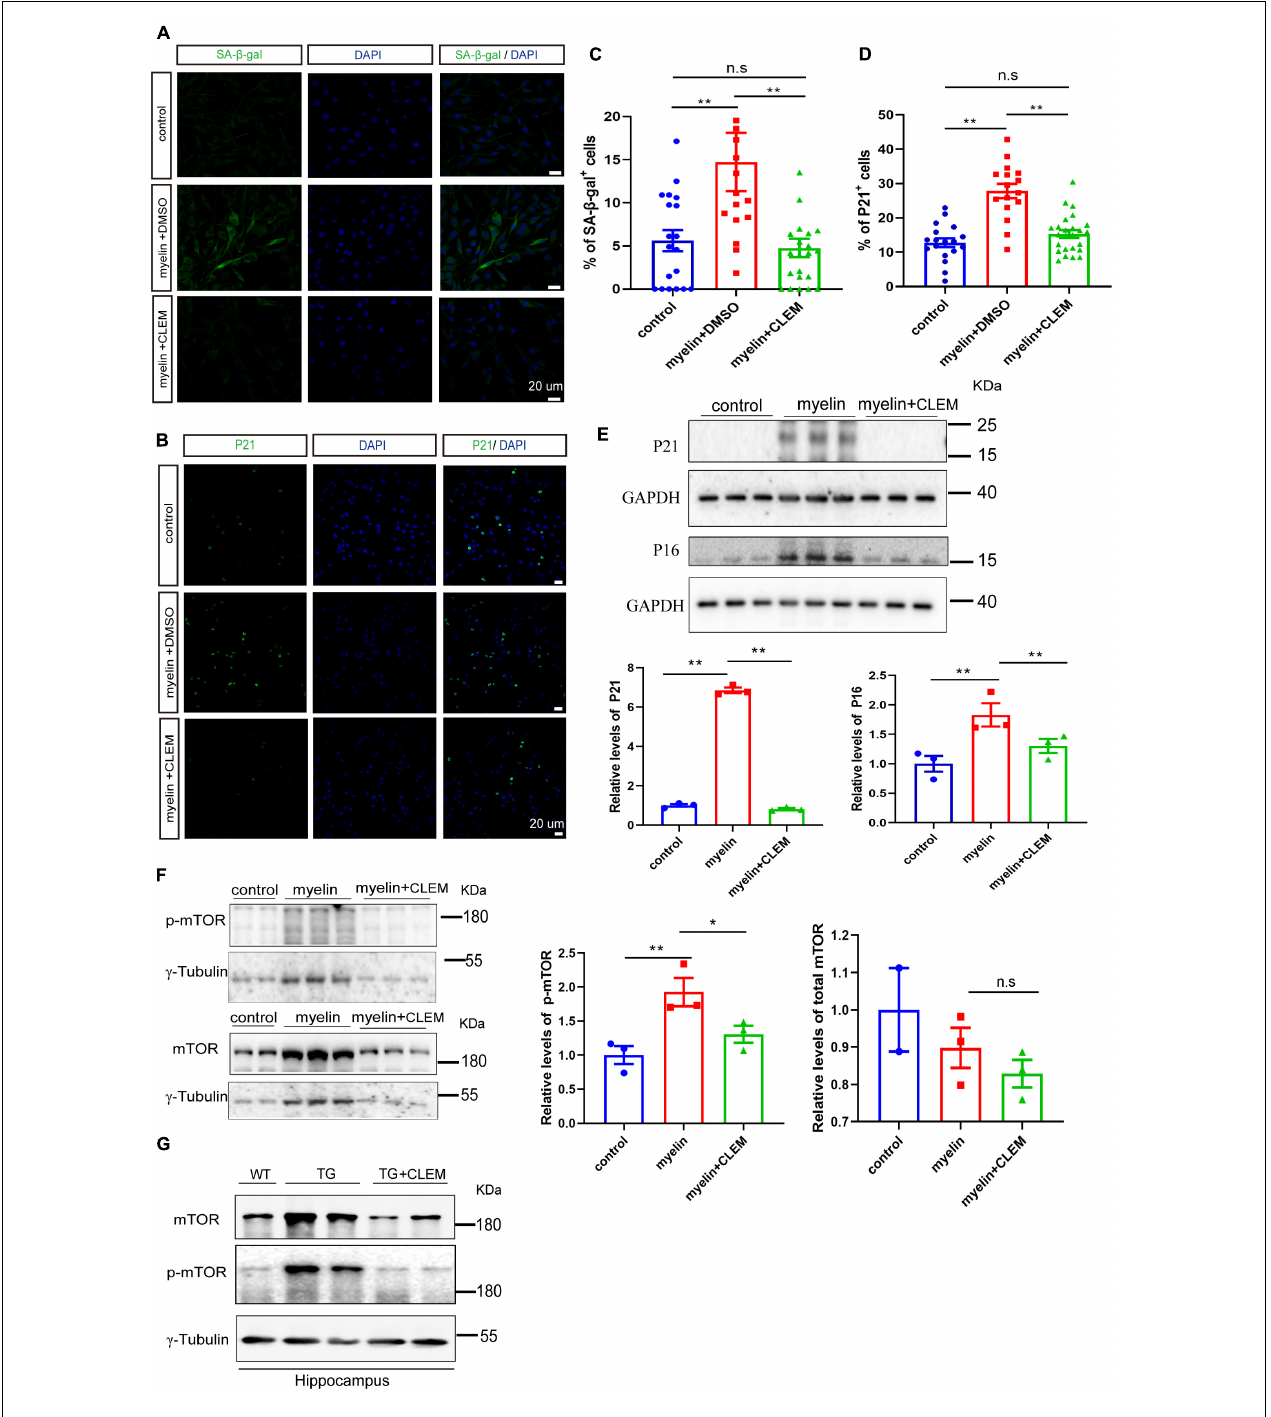
FIGURE 6 | Clemastine treatment prevents senescence of cultured glial cells. (A,B) Confocal images of immunolabeling OLN cells with SA- β -gal (A) or p21 (B) (green) and 4,6-diamidino-2-phenylindole (blue). Cells were either non-treated (control) or treated with myelin and dimethyl sulfoxide (myelin) or treated with myelin and clemastine (myelin + CLEM). (C,D) Quantification of numbers of SA- β -gal + cells (A) and numbers of p21 + cells (B) ; values shown are mean ± SE from three experiments. ** p < 0.01, one-way analysis of variance with Student’s t -test. (E,F) Western analysis of protein levels of p16 and p21 (E) , mTOR and p-mTOR (F) of cells treated with myelin and dimethyl sulfoxide (myelin), or myelin with clemastine (myelin + CLEM) or non-treated (control). GAPDH and γ -tubulin were served as loading controls for (E,F) , respectively. Ratio values were calculated as “p16 or p21/GAPDH,” “mTOR or p-mTOR/ γ -tubulin,” and normalized to ratio of control. Values shown represent mean ± SE. * p < 0.05, ** p < 0.01, n = 3. (G) Western analysis of protein levels of mTOR and p-mTOR in hippocampus of WT; APP/PS1 and APP/PS1 mice treated with clemastine; γ -tubulin was served as loading control.